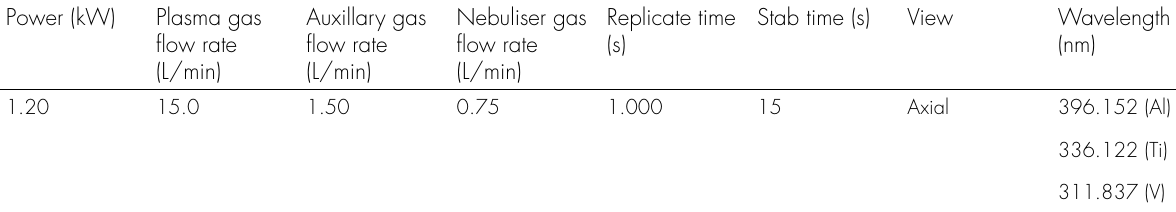
Table I. Operational parameters of